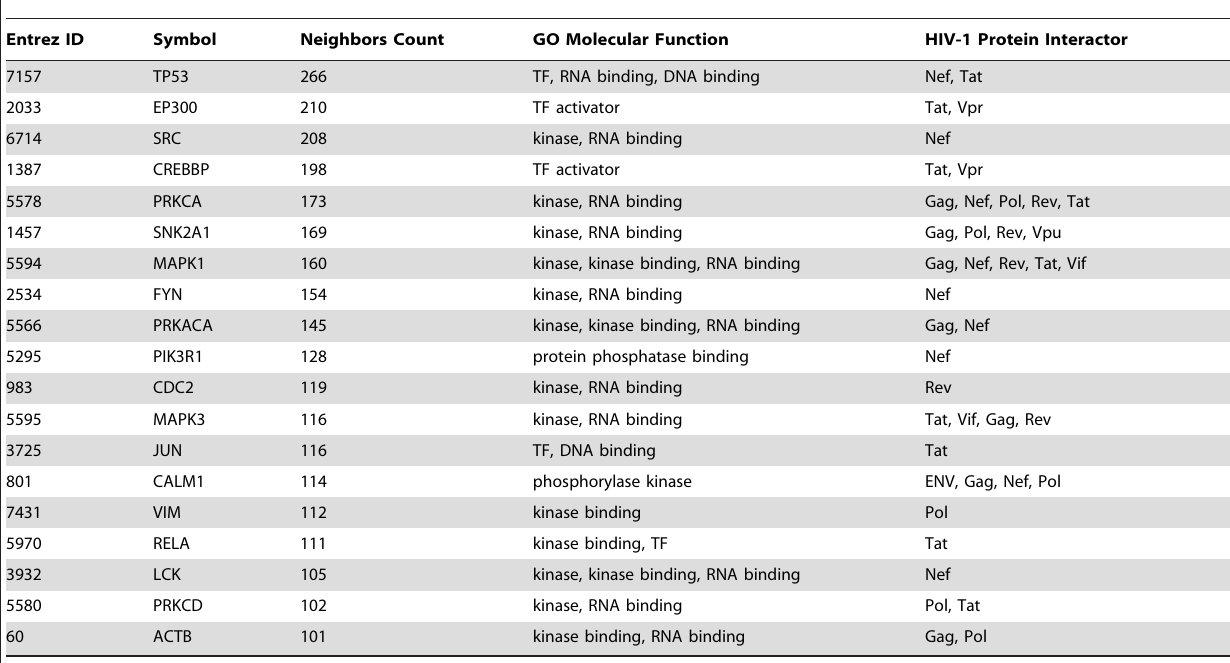
Table 1. List of host hub proteins targeted by